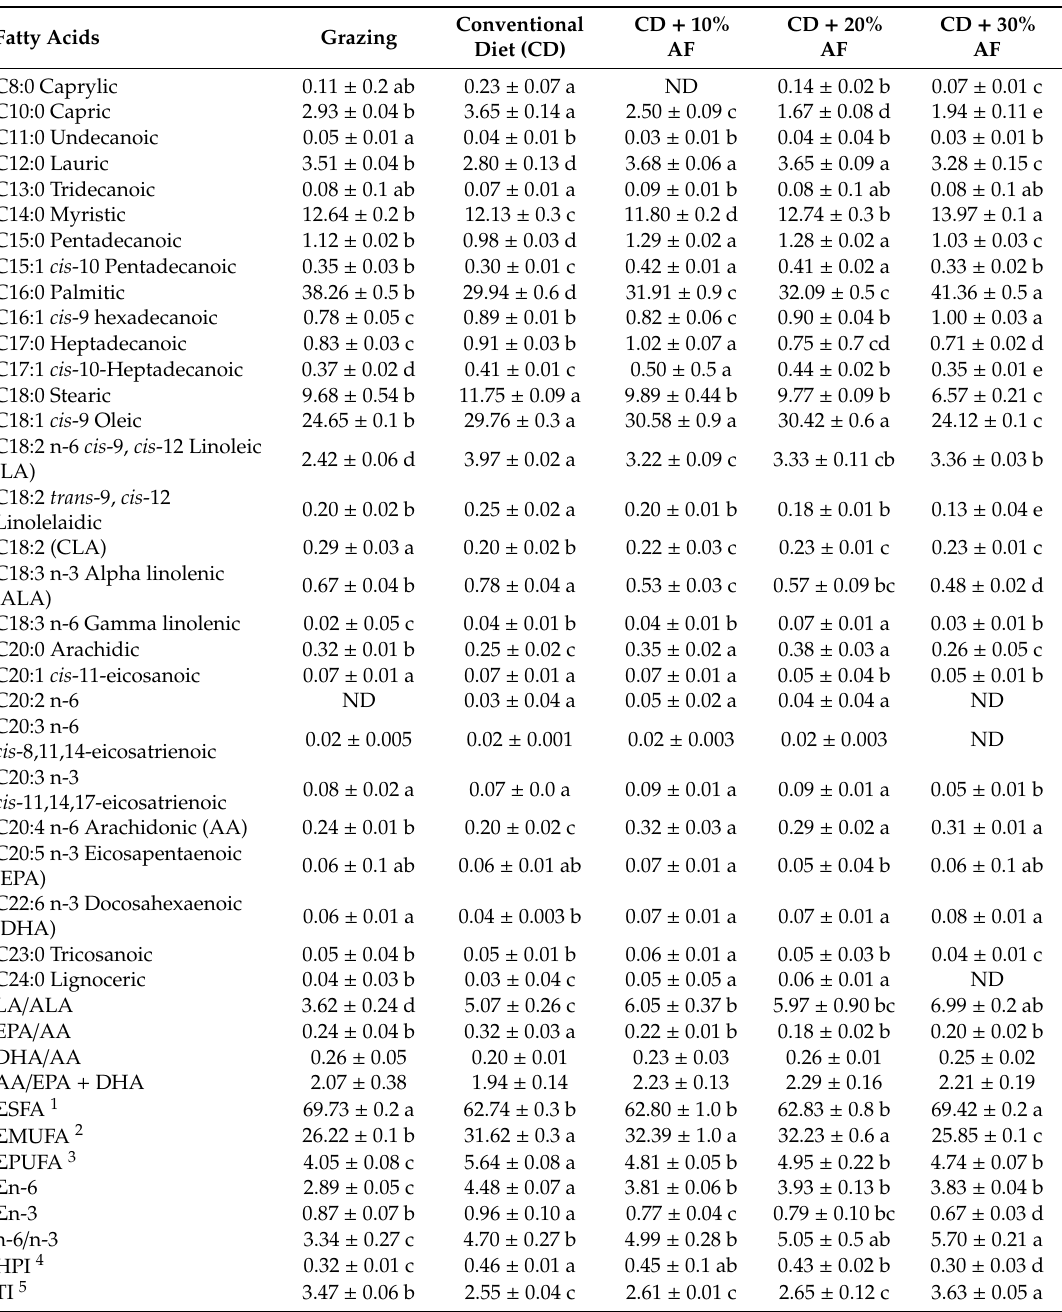
Table 3. Fatty acids profile (g / 100 g fatty acid methyl esters, FAME) and health / risk indices in the goat’s milk system from semiarid systems in